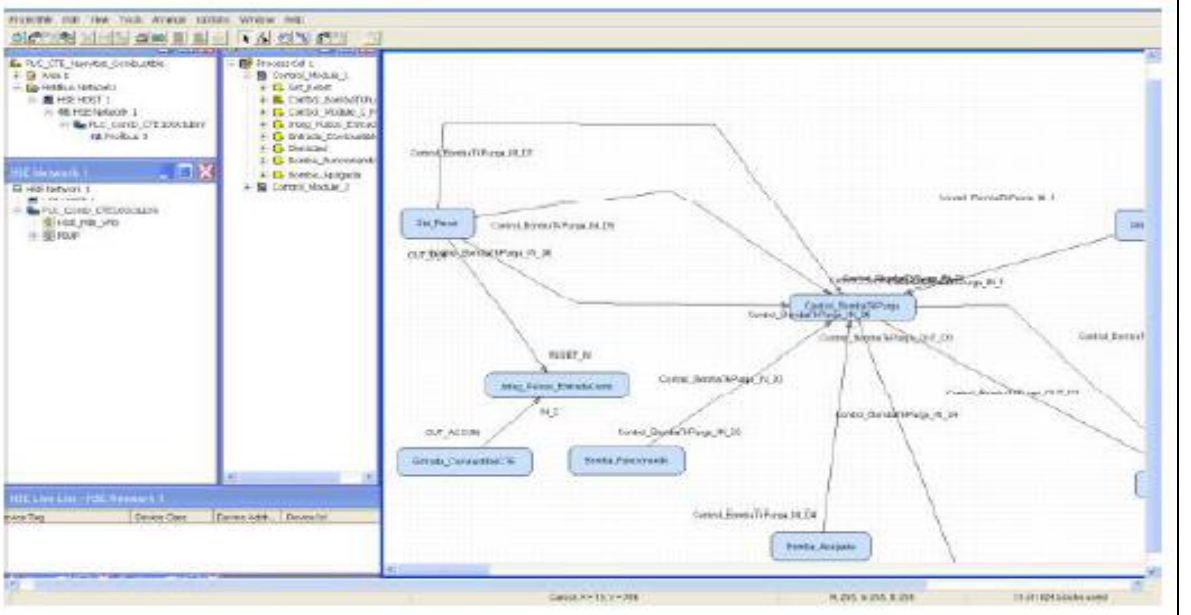
Figura 13: Porción de la programación del PLC Endress+Hauser usando el software Control Care Application Designer. Fuente: Los Autores, (2015).